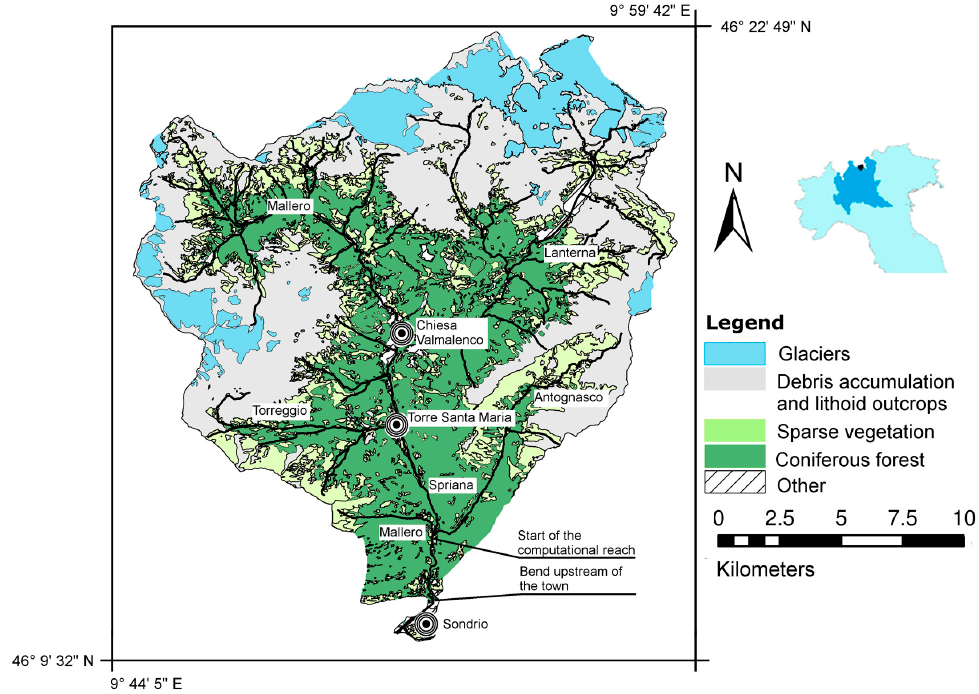
Figure 1. The Mallero catchments in Northern Italy with land cover, major streams, and towns.